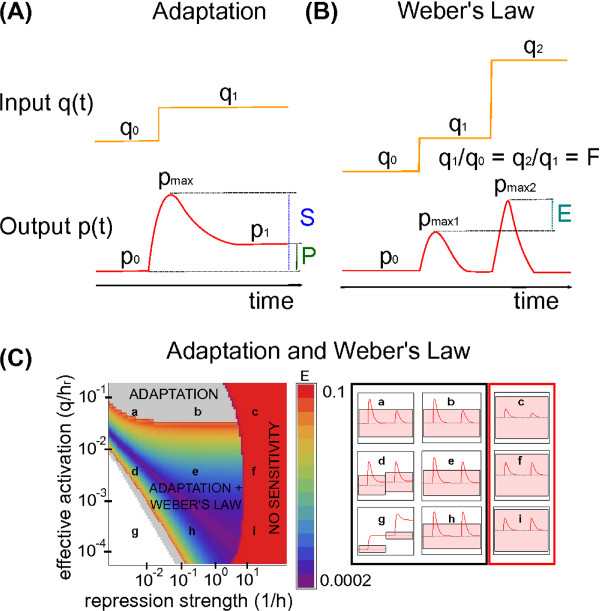
Adaptation and Weber’s law implementation via intronic miRNA-mediated self-regulation.(A) Schematic view of adaptative behaviour for a step-like input. S and P are the sensitivity and precision measures described in the main text. (B) Schematic view of Weber’s law implementation for a two-step input function. E is the error in fold-change detection, as defined in the main text. (C) A summarizing heat-map of the iMSL performances in implementing adaptation and Weber’s law, as a function of the effective activation q/hr and the repression strength 1/h. The grey region is the adaptive region (P > 10 and S > 2CVp), while the region where the system implements also Weber’s law (E < 0.1) is depicted with a color code representing the E value as reported in the legend. In the red zone the system is not sensitive enough to input variations (S < 2CVp). On the right, the target protein-level response to a two-step input is reported for the parameters values identified by the corresponding lower-case letters in the heat-map. The shaded regions correspond to the 2CVp sensitivity threshold, showing that for a too strong repression the circuit response cannot produce a signal beyond the noise level (plots in the red rectangle). The parameter setting is the following: mRNA and protein half-lifes as in Figure
2, miRNA half-life is τs = 8 hours, kr = 2.12819s−1, kp = 0.048s−1, the input function starts from an initial value of q0 = 40 and makes two consecutive steps with fold-change F = 4.